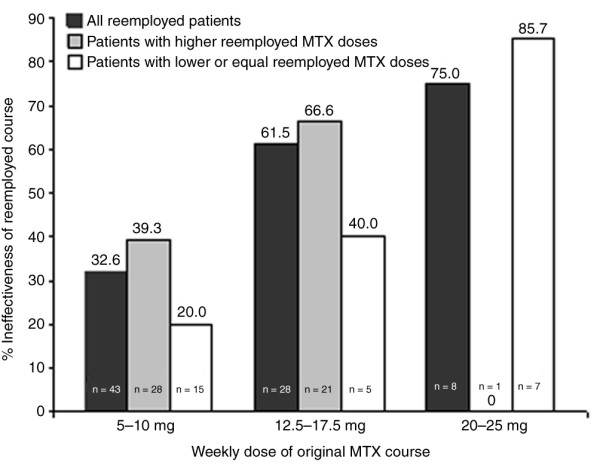
Ineffectiveness of re-employed courses in relation to dose of original course. Bars show the association of treatment termination of re-employed courses for ineffectiveness with the dose of the original methotrexate (MTX) course (total numbers shown in the bars). This relationship is shown for all re-employed courses (black bars; P = 0.02, by logistic regression), patients in whom MTX was re-employed at higher doses (grey bars; P = 0.43), and patients in whom MTX was re-employed at doses lower than or equal to the original courses (white bars; P = 0.01).